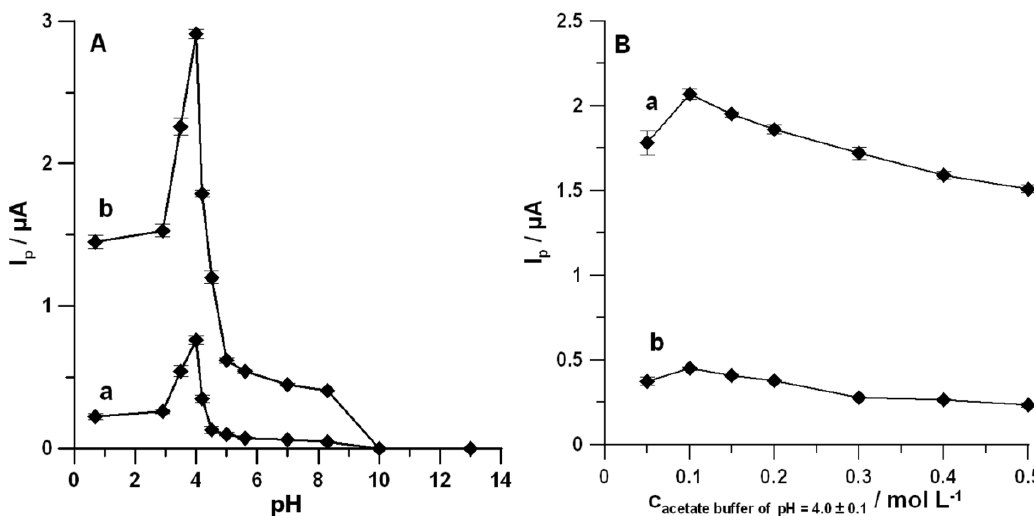
Figure 3. Effects of pH value ( A ) and concentration of the NaAc–HAc buffer solution with a pH value of 4.0 ± 0.1 ( B ) on DF current response. (a) and (b) in ( A ) are for the DF concentration of 0.05 and 0.1 µmol L −1 , respectively. (a) and (b) in ( B ) are for the DF concentration of 0.05 and 0.1 µmol L −1 , respectively. Other parameters are the same as in Figure 1.